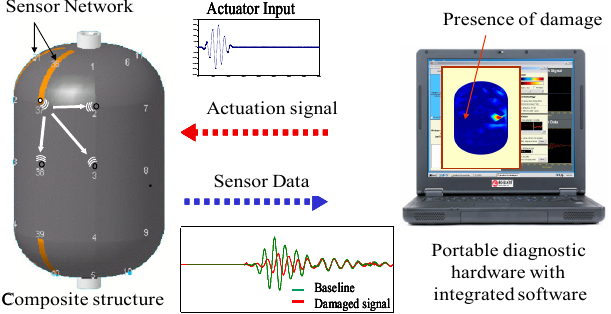
Figure 6. Principle of wave propagation-based SHM.